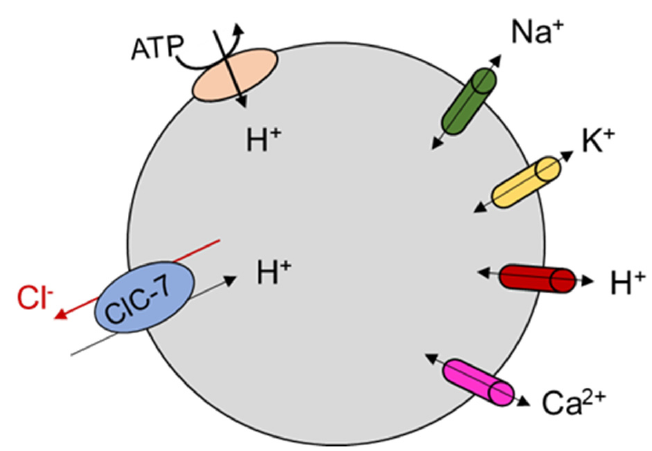
Figure 4. Schematic representation of the role of ClC-7 in lysosomes. Lysosomal acidification results from the complex interplay of anion and cation transport mediated by different families of ion channels and transporters. ClC-7 is indicated in light blue, V-type ATPase in light red. A variety of cation channels is also indicated. The orientation of Cl − and H + movement is suggested on the basis of the electrophysiological studies in which ClC-7 is expressed at the plasma membrane.